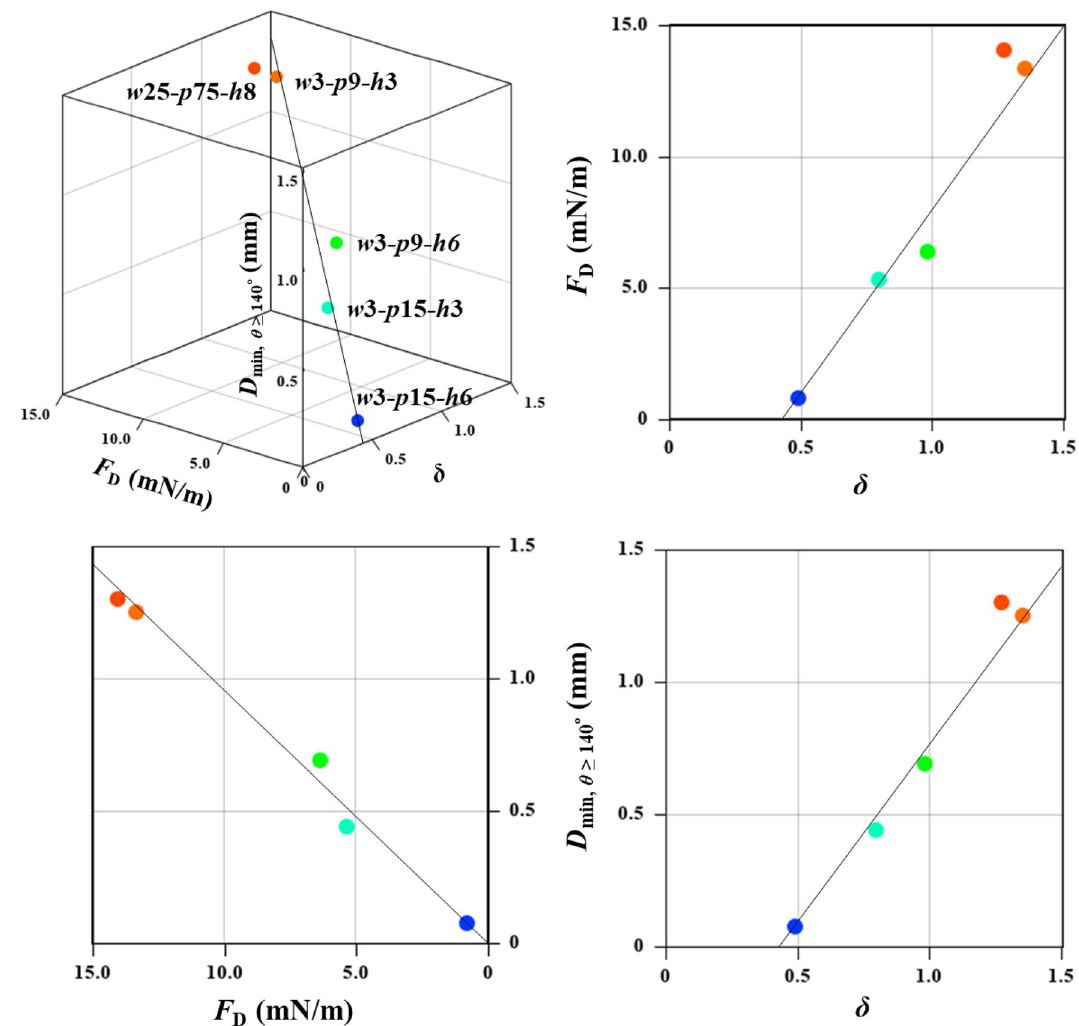
Figure 10. Wetting resistance ( D min, θ ≥ 140 ◦ ) as a function of δ and F D for five different